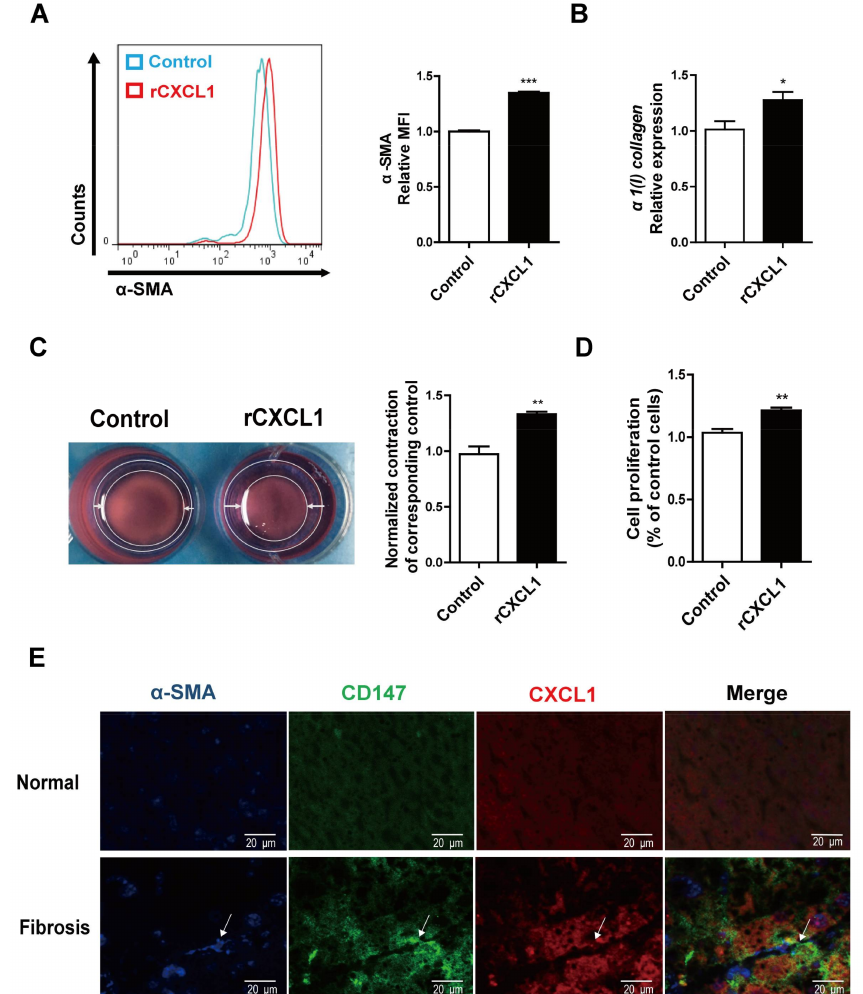
Figure 2. CXCL1 promoted HSCs activation and co-localized with CD147 in HSCs. ( A ) Flow cytometry analyses of α -SMA expression; ( B ) Real-time RT-PCR detection of α 1(I) collagen mRNA level. GAPDH was used as the normalization control; ( C ) Representative phase contrast images and quantitative analysis of collagen-based cell contraction; ( D ) CCK-8 assay; ( E ) Immunofluorescence detection of CD147, CXCL1 and α -SMA in liver tissues from normal control and CCl 4 -induced mice (eight weeks, n = 5). Arrows indicate α -SMA (blue), CD147 (green), and CXCL1 (red) expression in the activated HSCs. LX-2 cells were treated with 100 ng/mL rCXCL1 for 24 h. The results were shown as the mean ± SD. * p < 0.05, ** p < 0.01, *** p <